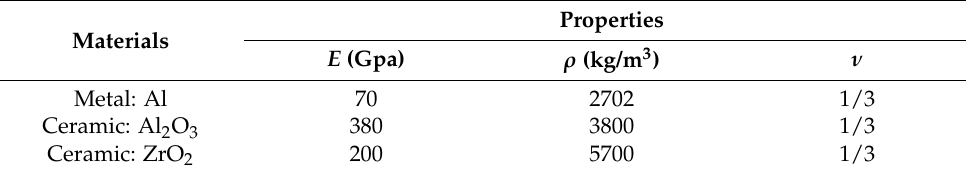
Table 1. Physical properties of the materials